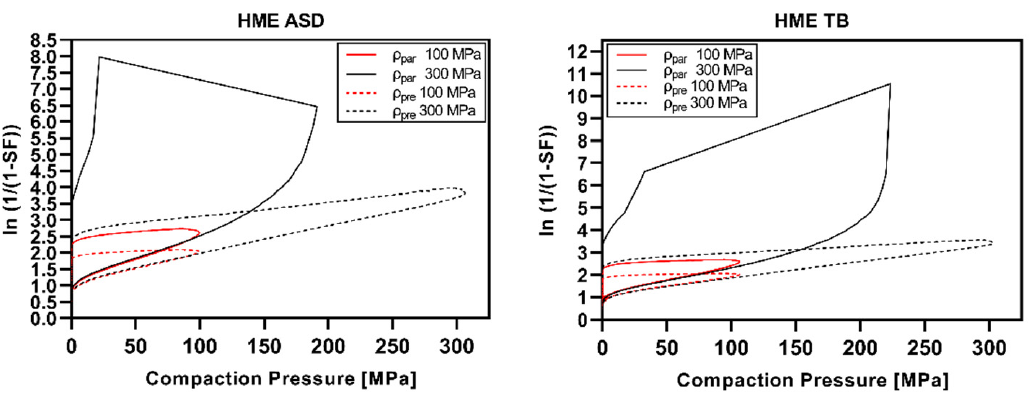
Figure 11. Heckel plots of HME ASD and HME TB at 100 and 300 MPa calculated using particle density ( ρ par ) or density under pressure ( ρ pre ).